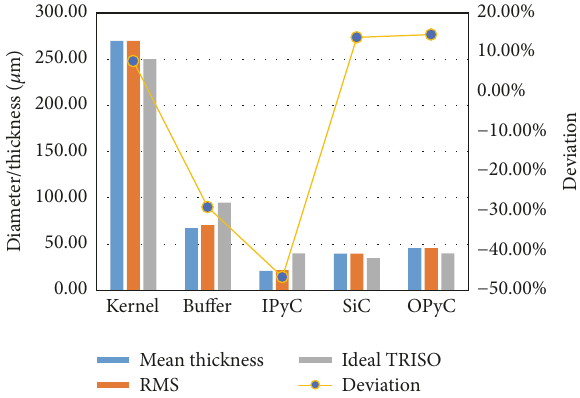
Figure 4: Measured thickness and design thickness of TRISO.